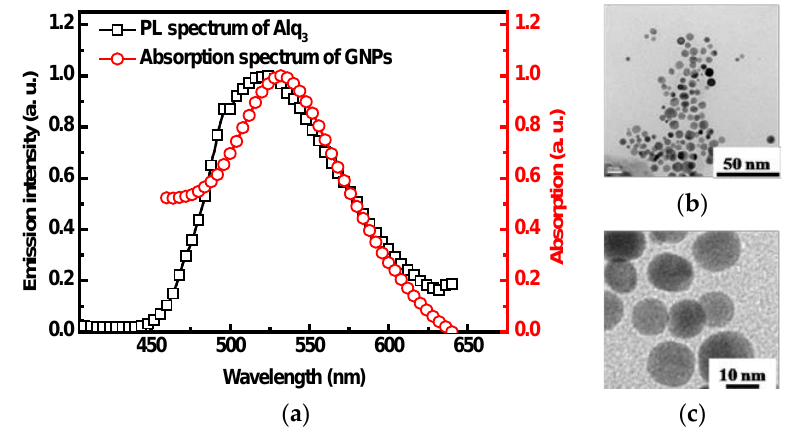
Figure 2. ( a ) Absorption spectrum of the GNPs and PL spectrum of the Alq 3 ; ( b ) TEM image of the GNPs; ( c ) High-resolution TEM images of the GNPs.